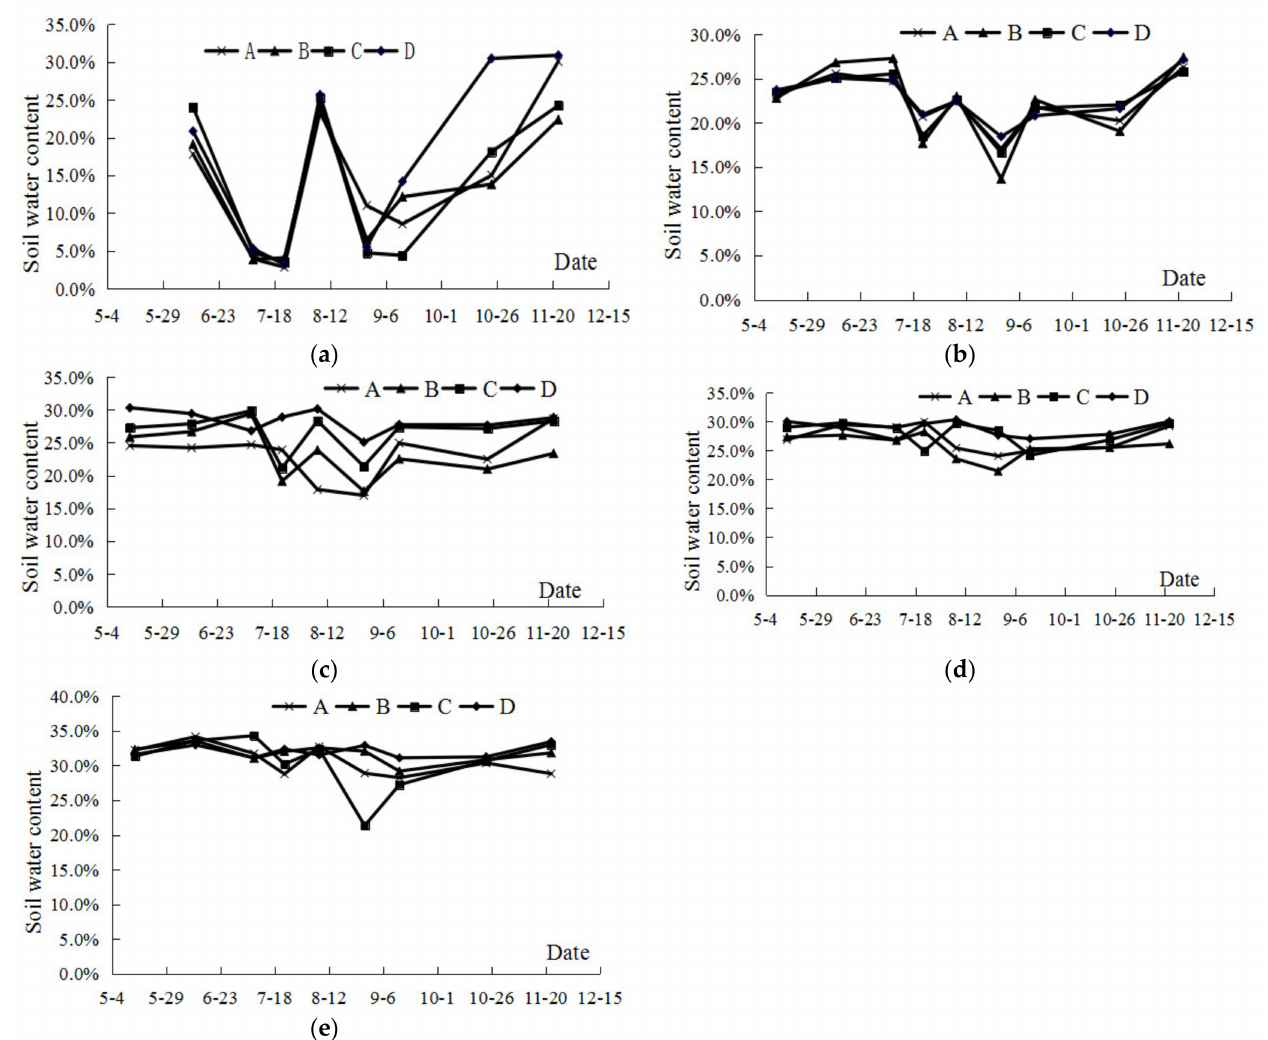
Figure 4. Variation in the soil water content in the different layers during the cotton growth period in the field in 2009. ( a ) Soil water content at the surface; ( b ) Soil water content in the 20 cm layer; ( c ) Soil water content in the 40 cm layer; ( d ) Soil water content in the 60 cm layer; ( e ) Soil water content in the 80 cm